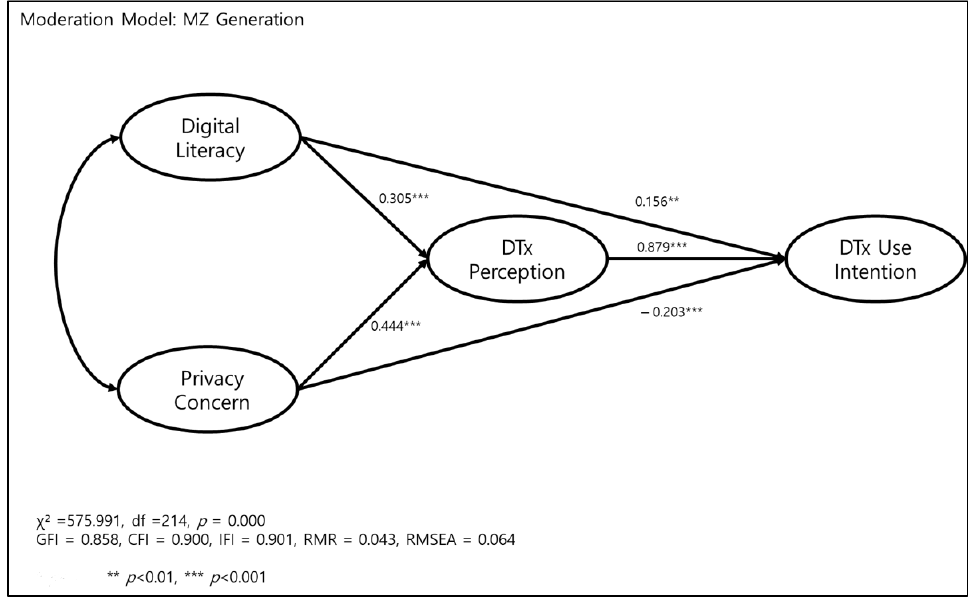
Figure 1. Effect of digital literacy and privacy concern on digital therapeutics (DTx) perception and digital therapeutics (DTx) use intention in MZ generation.